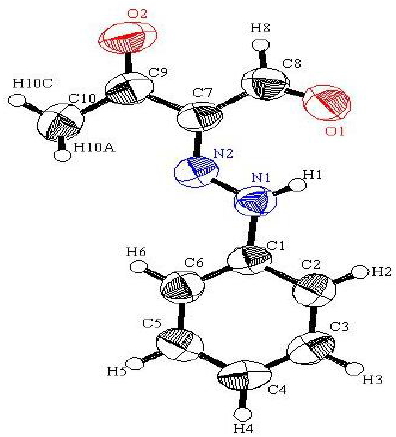
Figure 1. ORTEP drawing of 2d